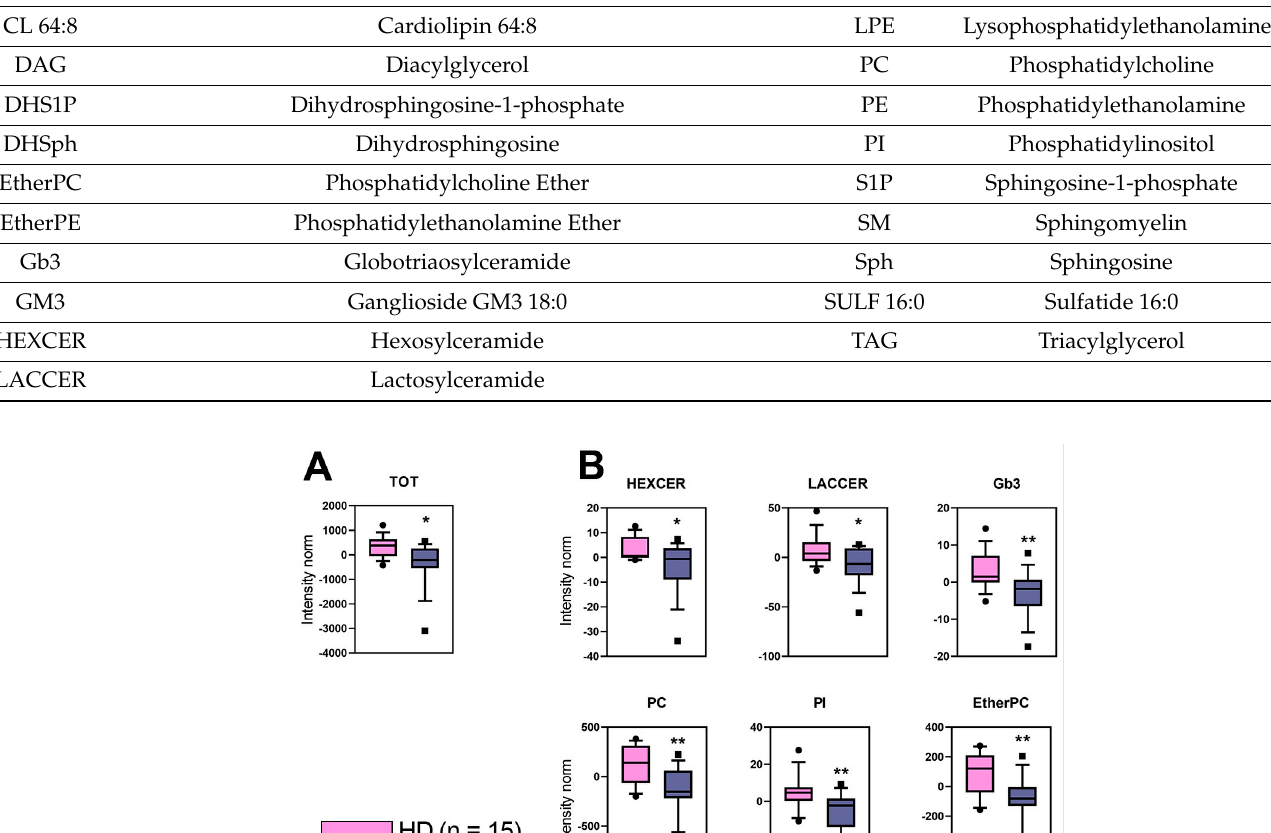
Table 1. Nomenclature of lipid species in MA plasma lipidomics.